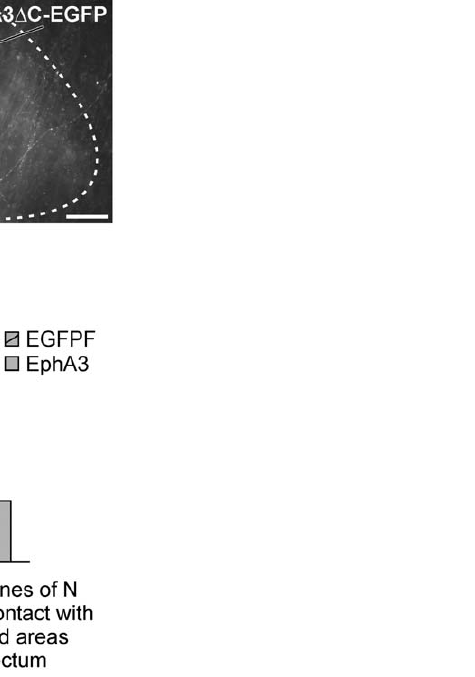
Figure 6. EphA3 ectodomain overexpression stimulates nasal optic fibers (OFs) passing throughout and inhibits termination zones (TZs) formation. After infection of the optic tectum at E2 with RCAS-BP-B-EGFPF (control) (A) or with RCAS-BP-B-EphA3 D C-EGFPN3 (B) and DiI labeling of the naso-dorsal retina at E16 (HH42), the tectum was analyzed in whole mounts at E18 (HH44). (A, B) Microphotographs show a termination zone (TZ) formed by nasal optic fibers in an EGFPF-positive domain located in the caudal tectum (A) and nasal optic fibers (OFs) passing throughout an EphA3 D C-EGFP- positive domain located in the caudal tectum (B). Dotted lines demarcate the overexpressed regions. Scale bars =50 m m. (C, D) Comparison between the proportions of temporal (C) and (D) nasal RGC axons (T RGC and N RGC) which form TZs in the areas which express EGFPF versus EphA3 D C-EGFP. Temporal RGC axons were evaluated in the rostral tectum whereas nasal RGC axons were evaluated in the caudal tectum. (C) No significant difference is detected between the proportion of temporal RGC axons which form TZs in EphA3 D C-EGFP-positive regions and in EGFPF-positive regions (control) in rostral tectum. (D) A significantly lower proportion of nasal axons form TZs in EphA3 D C-EGFP- positive regions than in EGFPF-positive regions (control) in caudal tectum (Student’s t test, n: 4 EphA3 D C-EGFP-overexpressed tecta versus 7 control tecta for temporal RGCs; n: 5 EphA3 D C-EGFP-overexpressed tecta versus 4 control tecta for nasal RGCs). Results are shown as mean + / 2 SE.